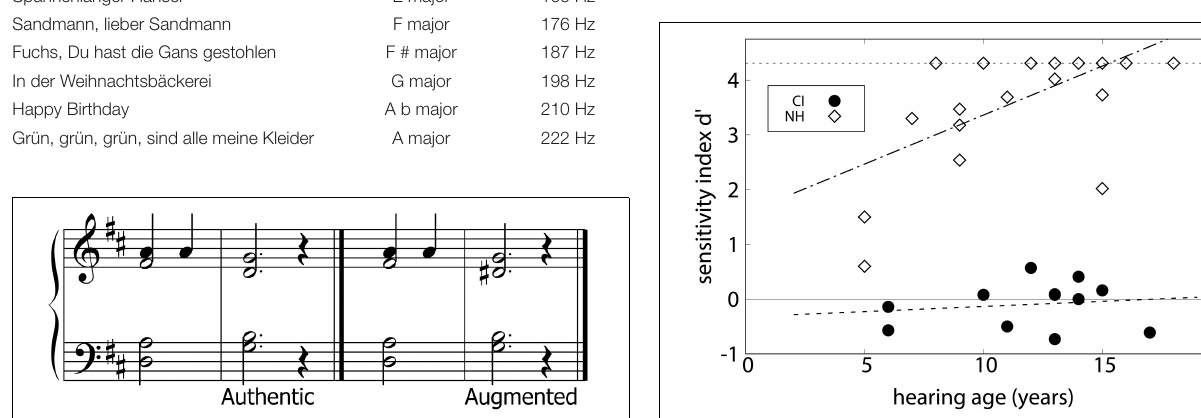
FIGURE 6 | Individual sensitivity indices d (cid:48) of the cadence judgment task are shown as a function of hearing age for CI listeners (circles) and NH listeners (diamonds) with corresponding correlation